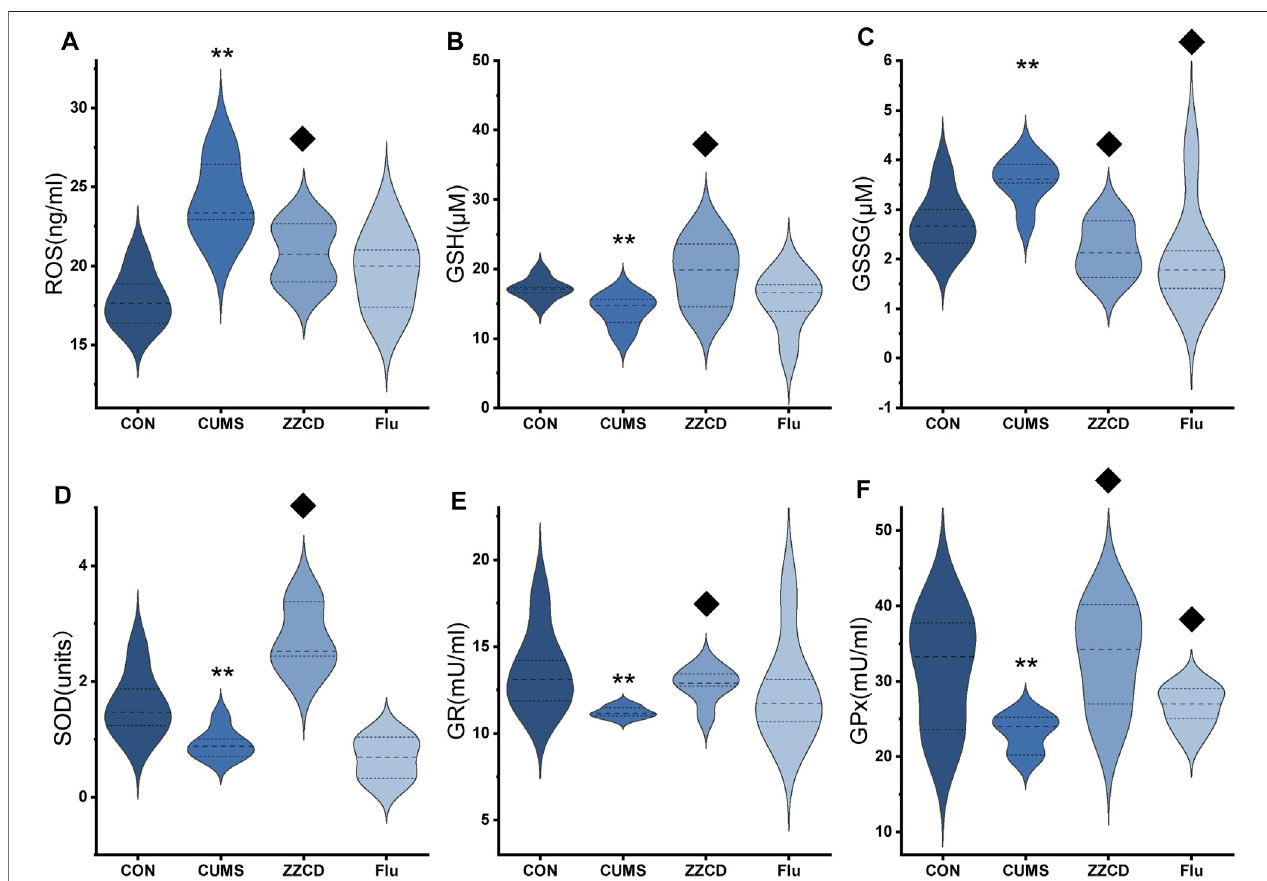
FIGURE4| EffectofZZCDonROS (A) production,GSH (B) andGSSG (C) level,GR (D) ,GPx (E) ,andSOD (F) activitiesinbrainsamplesofCUMSrats.** p < 0.01 vs. CON; ◆ p < 0.05 vs.